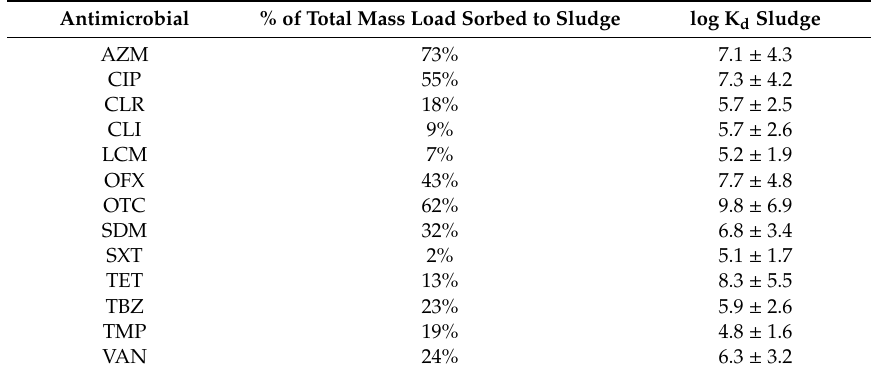
Table A2. Mean values of sorption coe ffi cients (log K d ) calculated for sludge and the percent of the total mass of the compound sorbed in sludge to its total daily mass load to WWTP.